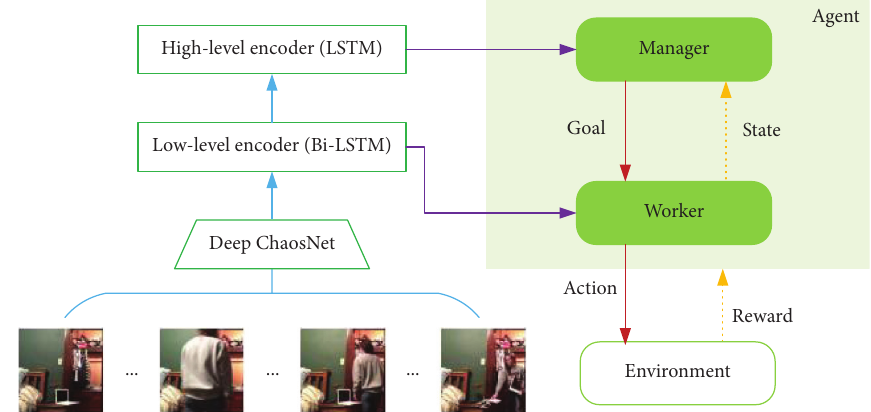
Figure 1: Illustration of the pipeline of the proposed deep ChaosNet feature extraction.